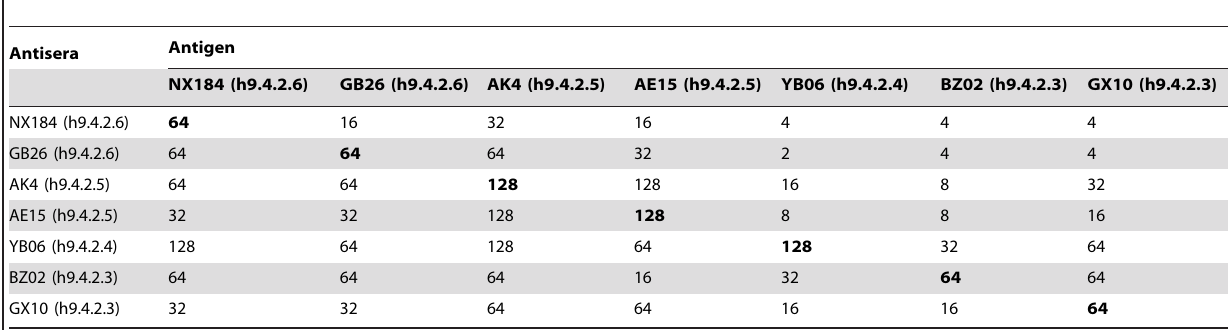
a Homologous titers are in boldface; lineage designations are in parentheses; virus designations are abbreviated as follows: NX184=A/chicken/Ningxia/NX184/2011, GB26=A/chicken/Guizhou/GB26/2011, AK4=A/chicken/Anhui/AK4/2011, AK15=A/chicken/Anhui/AK15/2011, YB06=A/chicken/Shandong/YB06/2006,